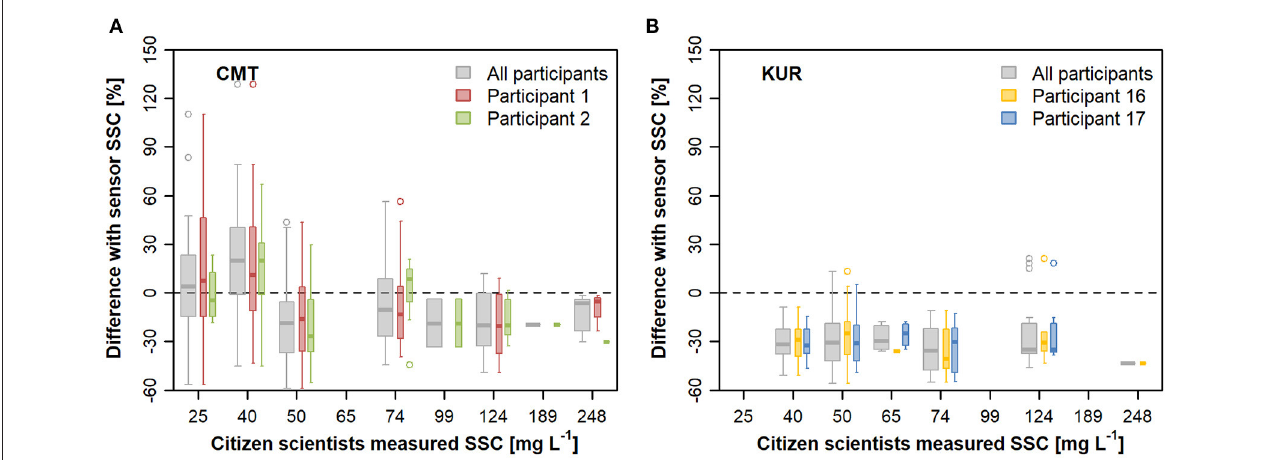
FIGURE 4 | Relative difference between citizen scientists measured SSC (mg L − 1 ) using turbidity tubes and the SSC (mg L − 1 ) obtained from turbidity data recorded by an in situ UV-Vis sensor at the corresponding automated station for (A) CMT and (B) KUR. The gray boxplots show the relative difference for all participants at a given site. Participant number corresponds to the participant ID shown in Figure 6